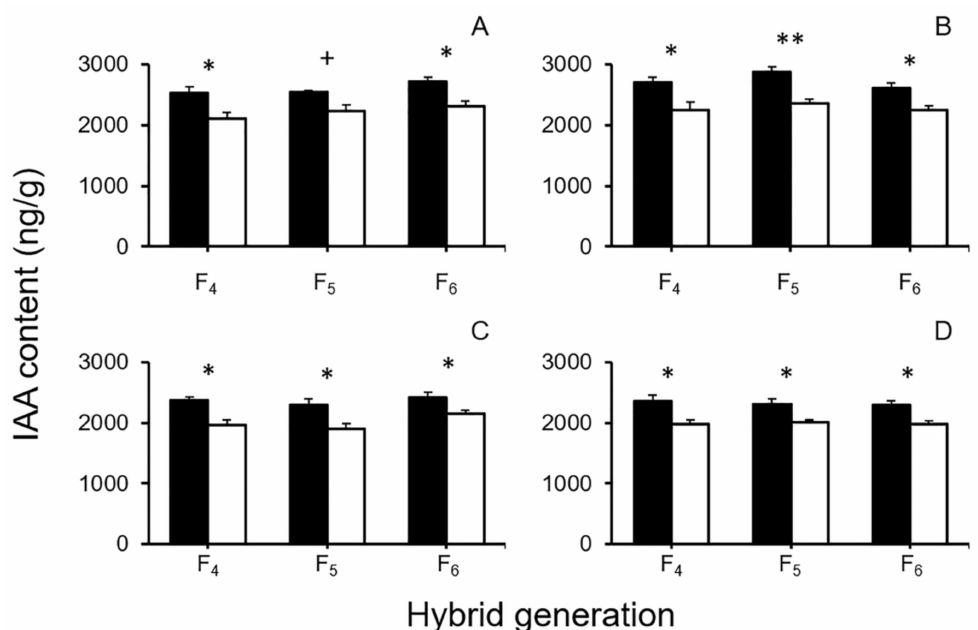
Figure 7. Average IAA contents of GE and non-GE crop (EP3)–wild rice (w1 or w2) hybrid seeds (F 4 –F 6 ). ( A , B ) dry seeds of EP3–w1 and EP3–w2; ( C , D ) imbibed seeds of EP3–w1 and EP3–w2. Comparisons were made between GE (black columns) and non-GE (white columns) seeds based on the independent-sample Student’s t -test. Bars represent standard error ( n = 3 replicates). + p < 0.1, * p < 0.05, ** p <